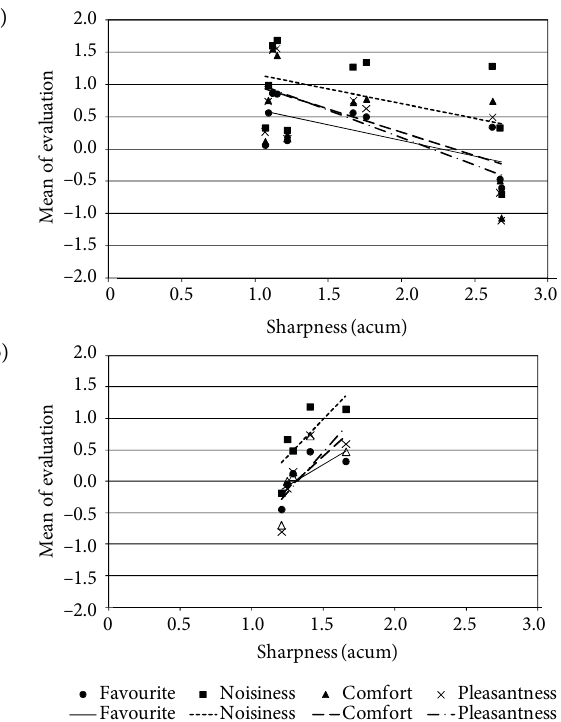
Fig. 6. Correlations between sharpness and the subjective evaluations of favourite, noisiness, comfort, and pleasantness for (a) single sound; (b)